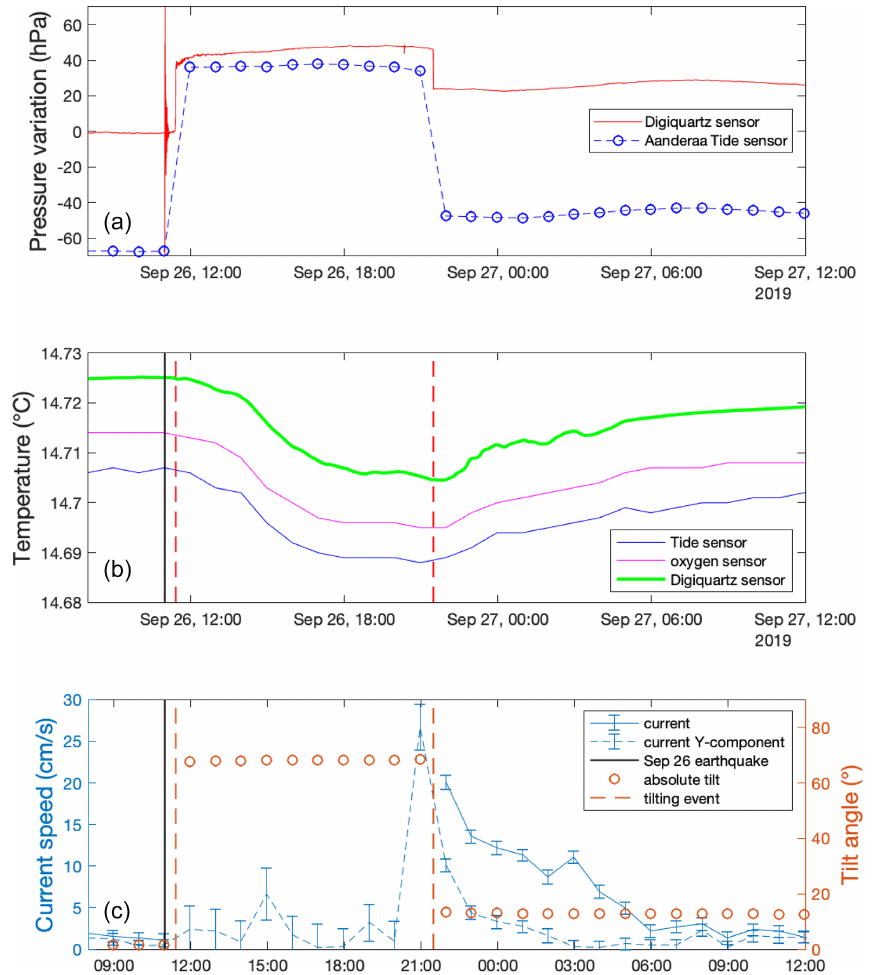
Figure 4. Time series around the time of occurrence of a M w 5.8 earthquake: (a) pressure variations recorded by two instruments on the instrumented frame; (b) temperature records from Digiquartz, tide and oxygen sensors; and (c) current and tilt data recorded by a SeaGuard RCM. Between the tilting events only one component of the Doppler current meter functioned reliably ( y component oriented N200 ◦ ) and is here